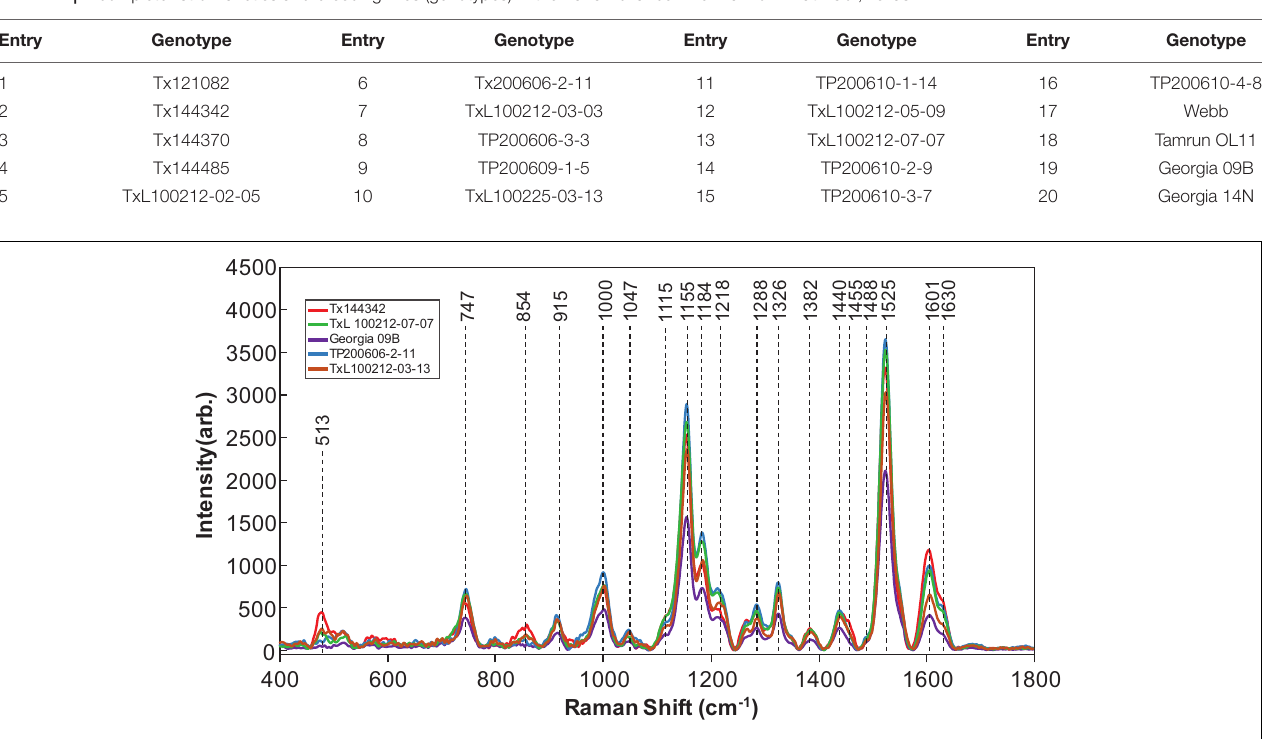
TABLE 1 | A complete list of varieties and breeding lines (genotypes) in the 2020 Advance Line Trial from Erath Co., Texas.